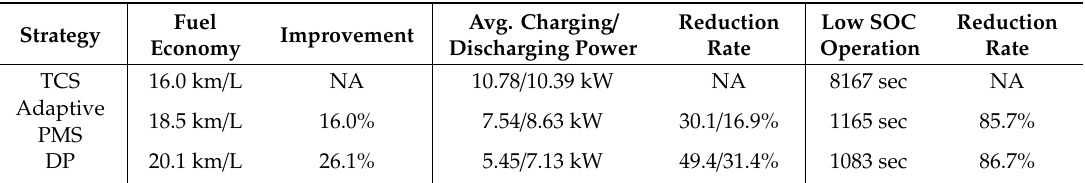
Table 6. Comparison of TCS, adaptive PMS and DP for 9 UDDS.